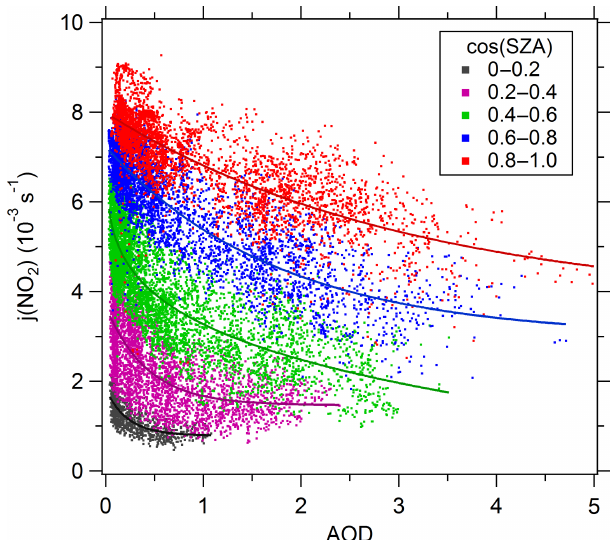
Figure 7. Dependence of j (NO 2 ) on AOD (380nm) in different SZA classes. The classes of cos(SZA) are 0–0.2 (black), 0.2–0.4 (purple), 0.4–0.6 (green), 0.6–0.8 (blue), and 0.8–1 (red). The full lines are fitted by the exponential